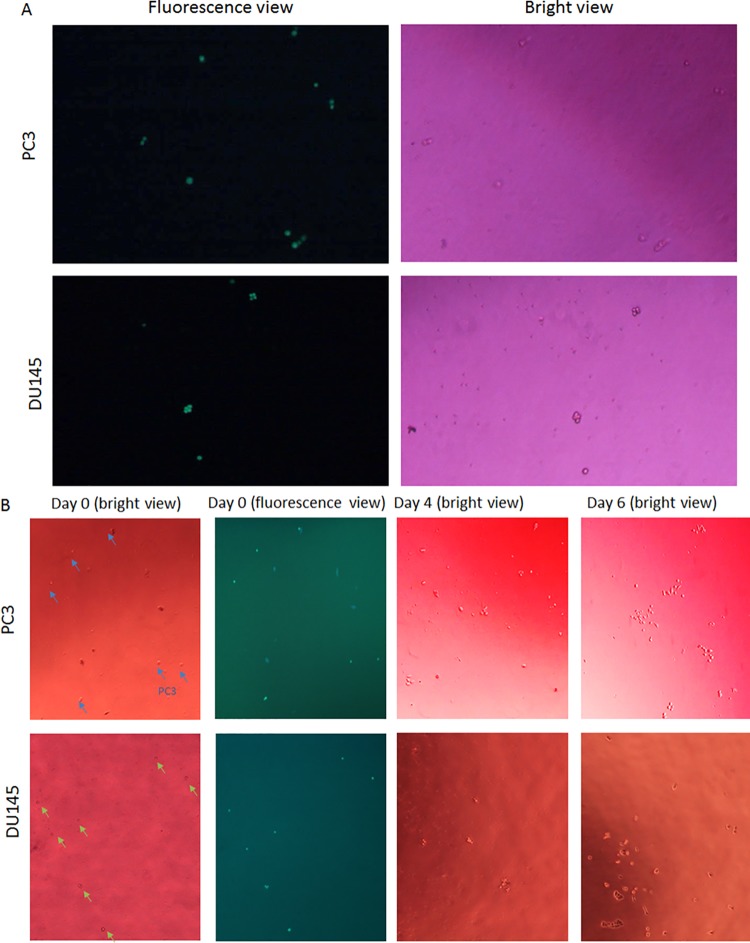
Viability of prostate cancer cell lines after isolation.(A) Pre-labeled cancer cell lines (labeled green) were identified with fluorescence microscope and then viewed in bright light to determine whether they were dyed with Trypan blue. Cells with clear cytoplasm were considered viable. (B) Cancer cells were cultured after isolation. Spiked pre-labeled cells (indicated by arrow) in 24-well plate, which were relative bigger and brighter comparing surrounding lymphocytes, under bright light and fluorescence views of the same area for spiked cells (labeled green) were present. Cancer cells attached to the plate bottom and started to proliferate on Day 4., They had grown well to form obvious clusters of proliferating cells by Day 6.